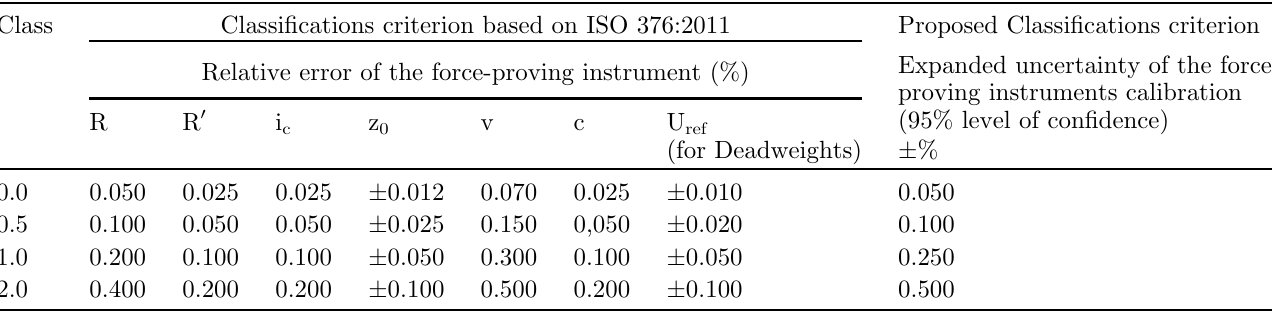
Table 5. Boundaries for force proving instruments for ISO 376 compared with the new proposed approaches. Class Classi fi cations criterion based on ISO